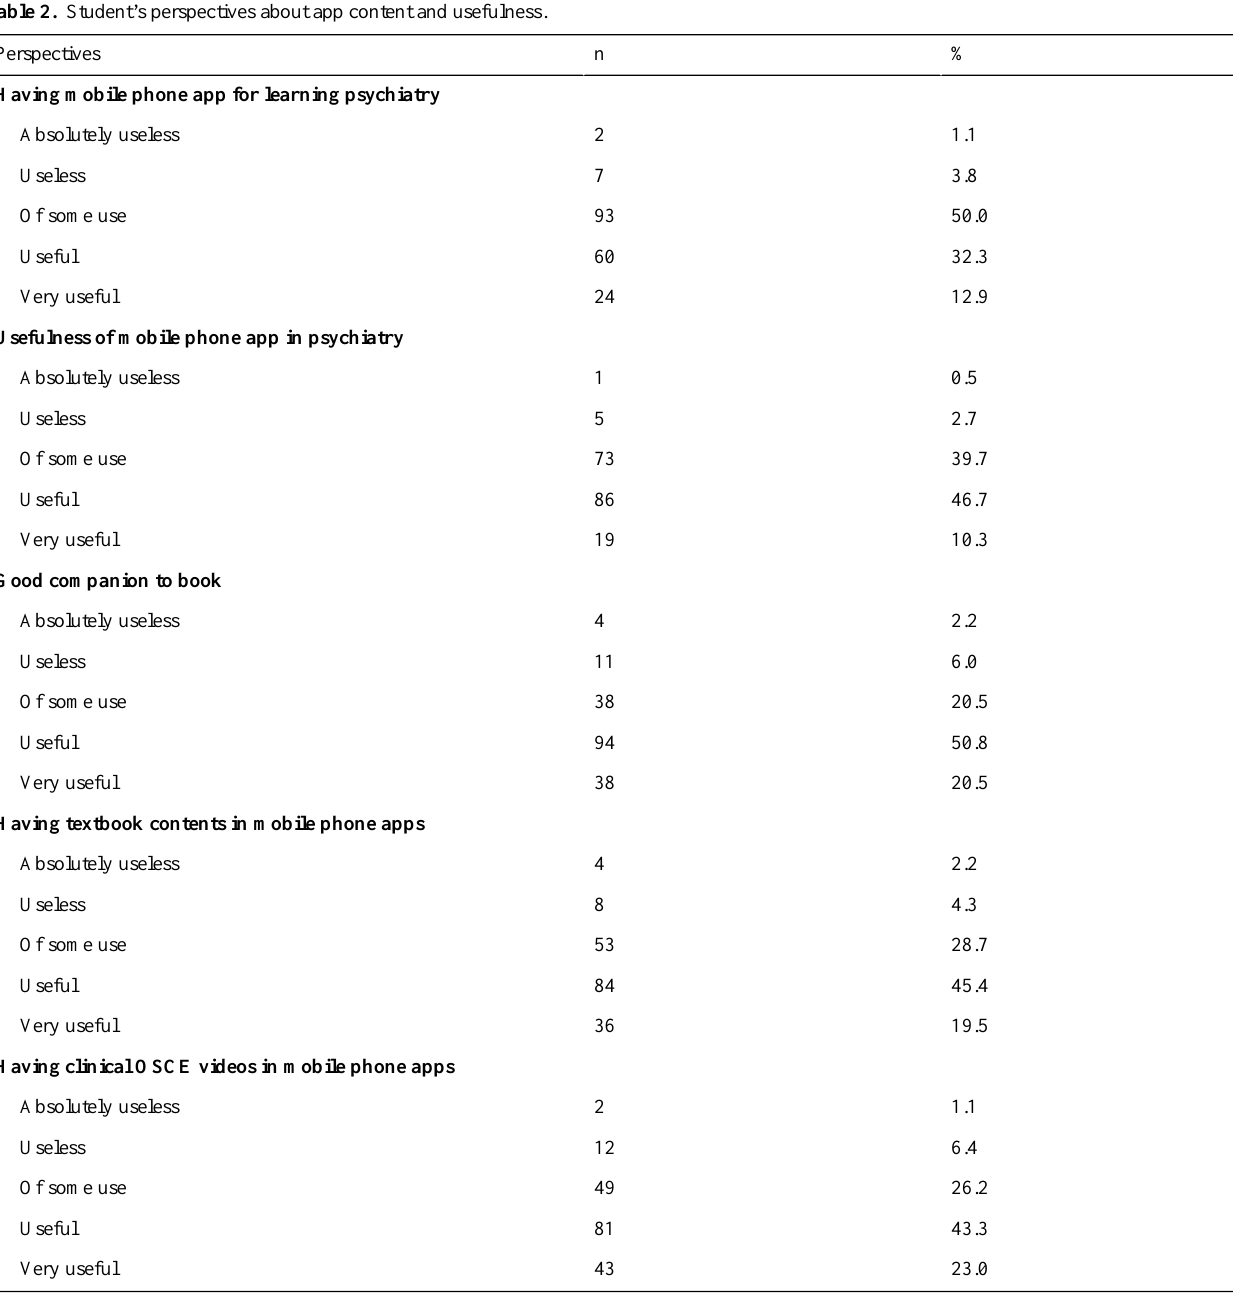
Table 2. Student’s perspectives about app content and